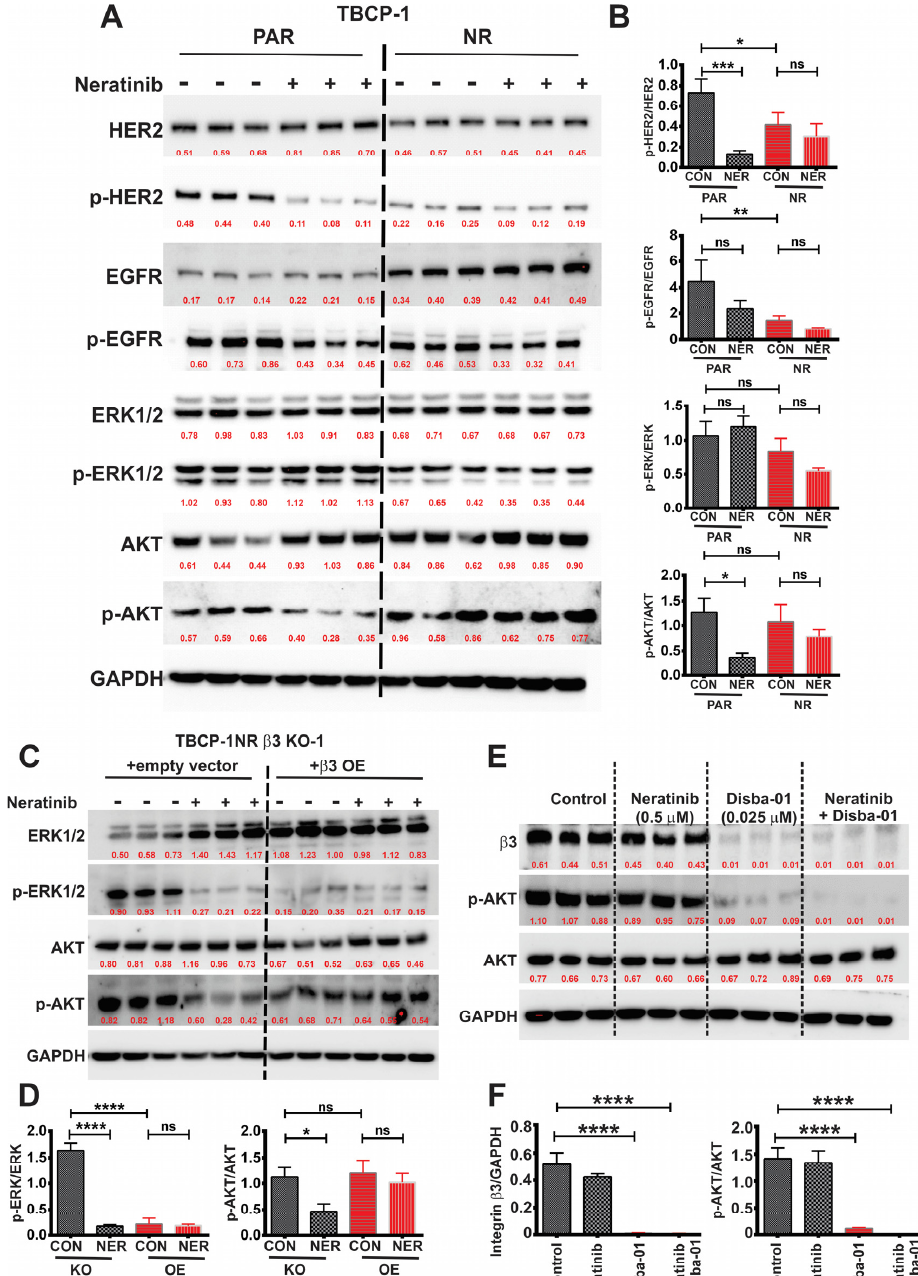
Figure 4. Integrin β 3 signals through AKT activation in TKI-resistant cells. ( A ) The impact of neratinib treatment on EGFR-HER2 signalling was analysed in TBCP-1 age-matched sensitive (PAR) and TKI-resistant (NR) cells. Changes in the levels of the indicated signalling intermediates were measured by Western blot in serum-starved cells following 1 h of vehicle control (DMSO) or neratinib (0.5 µ M) treatment and 10 min EGF stimulation. GAPDH was used as the loading control. The intensity ratio of each band relative to GAPDH is indicated in red. ( B ) Data shows quantitation of mean phospho/total protein ratio ± SD from three independent experiments ( n = 3). Statistical significance was determined by one-way ANOVA, Holm–Sidak’s multiple comparison test, p < 0.05 was considered significant, * p < 0.05, ** p < 0.005, *** p < 0.001, ns = not significant. ( C ) The impact of neratinib treatment on ERK and AKT phosphorylation was analysed in TBCP-1NR integrin β 3 KO cells transduced with empty vector or integrin β 3 OE